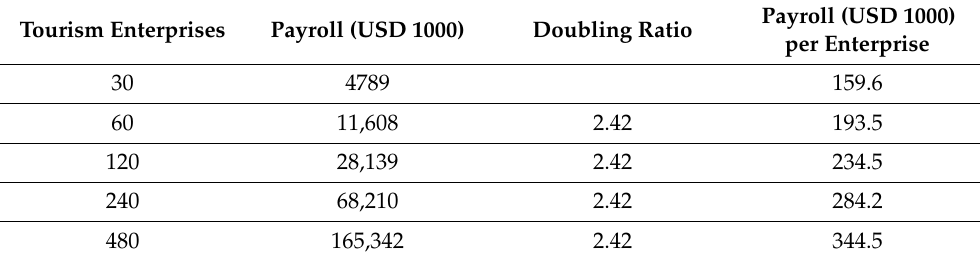
Figure 8. The power-law relationship between the number of tourism enterprises and tourism payrolls in United States micropolitans. Table 7. Tourism payrolls in relation to the number of tourism enterprises in United States micropoli- tans. The power law in Figure 8 was used in the